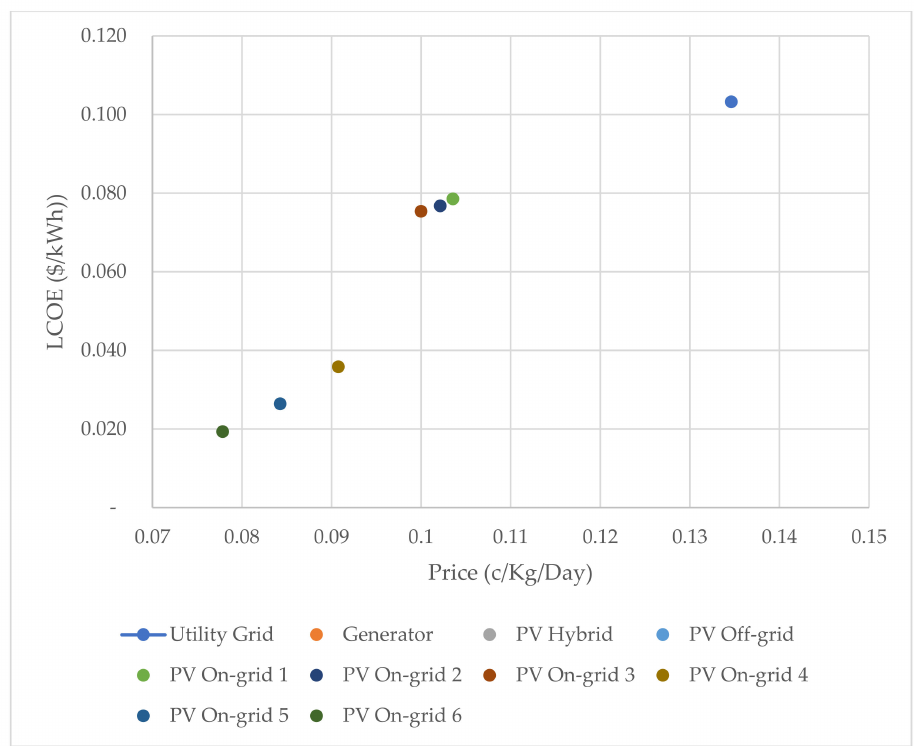
Figure 11. LCOE and Rent Price of Cold Storage for Commercial-based [28].